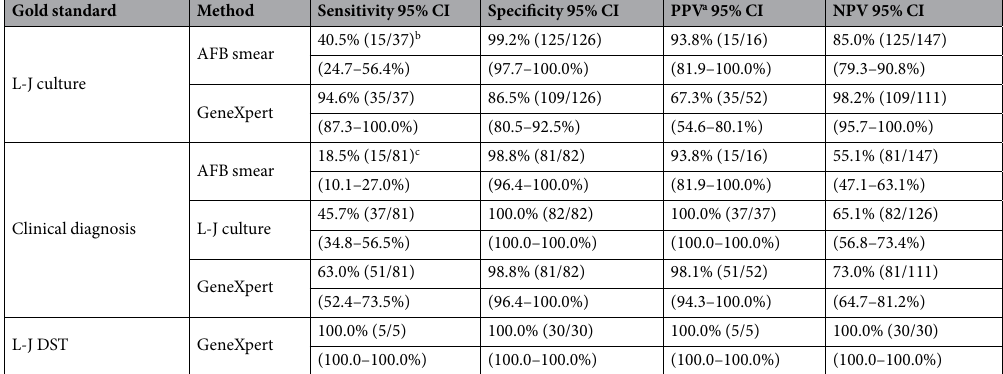
Table 2. Performance of Xpert, AFB smear and solid culture for the diagnosis of urinary tuberculosis in urine samples. a PPV, positive predictive value; NPV, negative predictive value; AFB, acid-fast bacilli; L-J, L ӧ wenstein- Jensen. b L-J culture was set as gold standard: χ 2 = 24.67, P < 0.001 (AFB smear Se. vs. GeneXpert Se.). c Clinical diagnosis was set as gold standard: χ 2 = 33.14, P < 0.001 (AFB smear Se. vs. Genexpert Se.); χ 2 = 13.71, P < 0.001 (AFB smear Se. vs. L-J culture Se.); χ 2 = 4.88, P = 0.027 (L-J culture Se. vs. GeneXpert